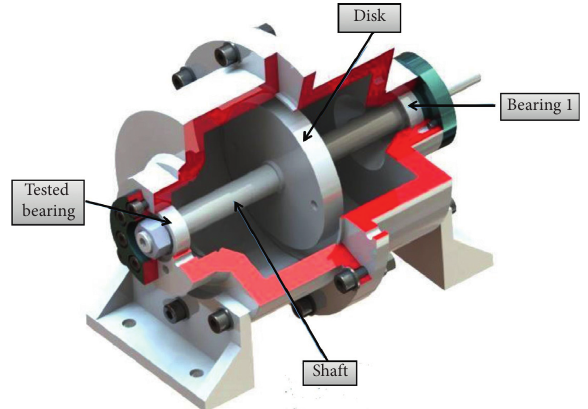
Figure 3: Schematic of test